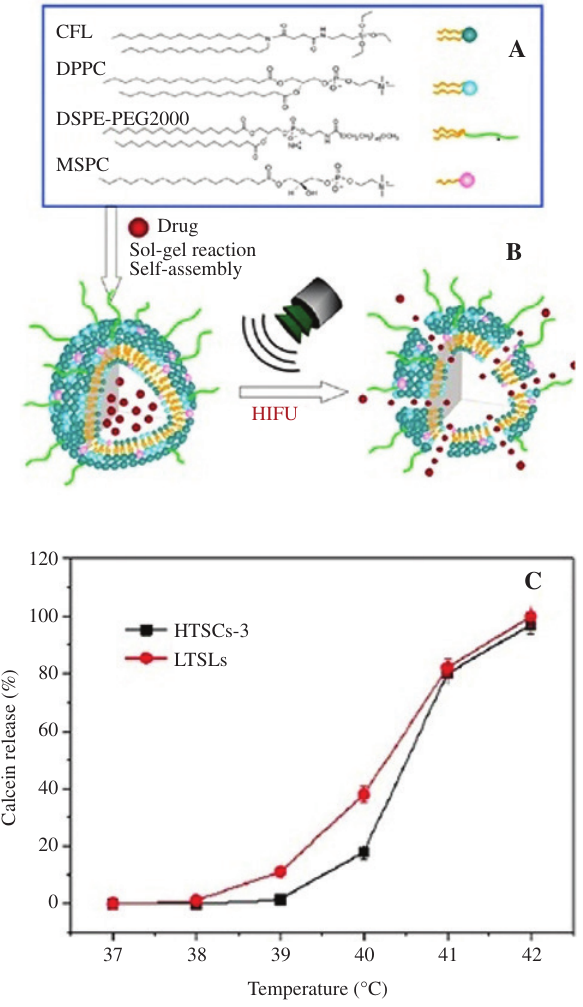
Figure 2: Ultrasound-sensitive drug-loaded liposomal cerasome. (A) Schematic of the formation of drug-loaded nanohybrid liposomal cerasome and its drug release on exposing the system to HIFU